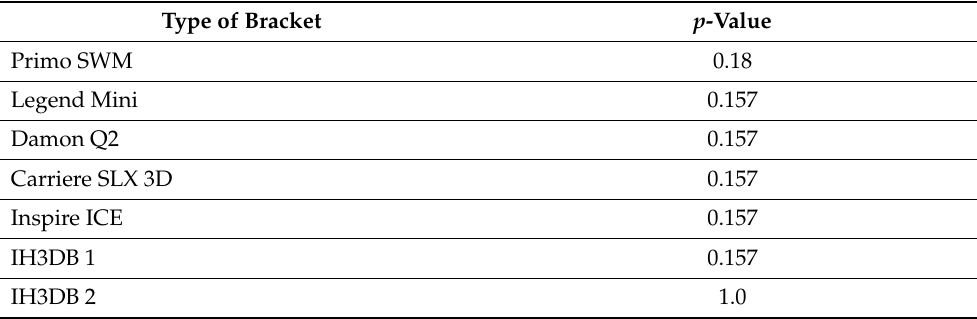
Table 2. Analysis of the repeatability of measurements by Wilcoxon’s non-parametric test ( p < 0.05). Type of Bracket p -Value Primo SWM 0.18 Legend Mini 0.157 Damon Q2 0.157 Carriere SLX 3D 0.157 Inspire ICE 0.157 IH3DB 1 0.157 IH3DB